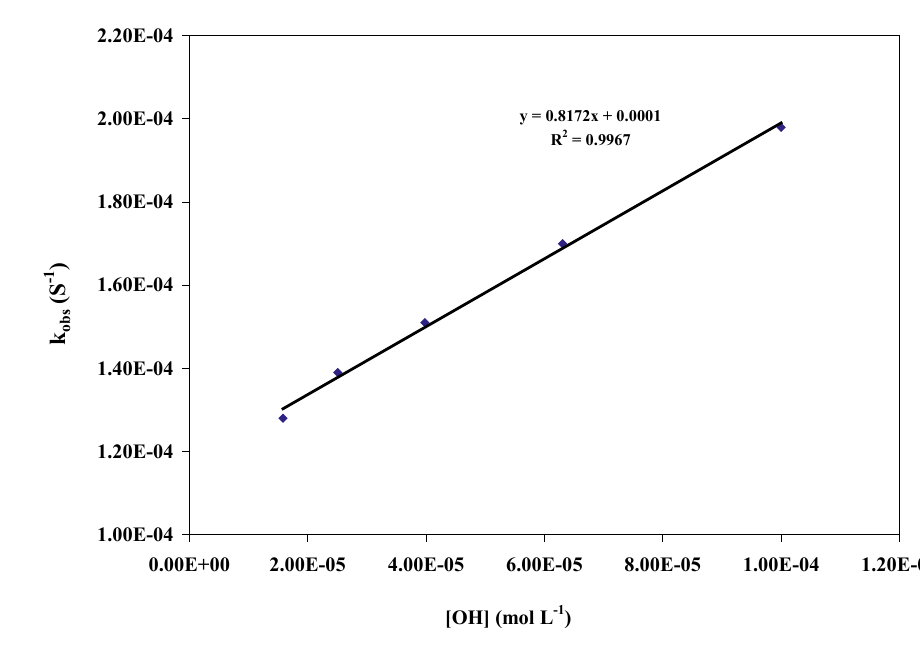
Figure 4. Effect of OH- concentration on kobs for the hydrolysis of histidine methyl ester coordinated to Pd(pip) complex at 25°C.